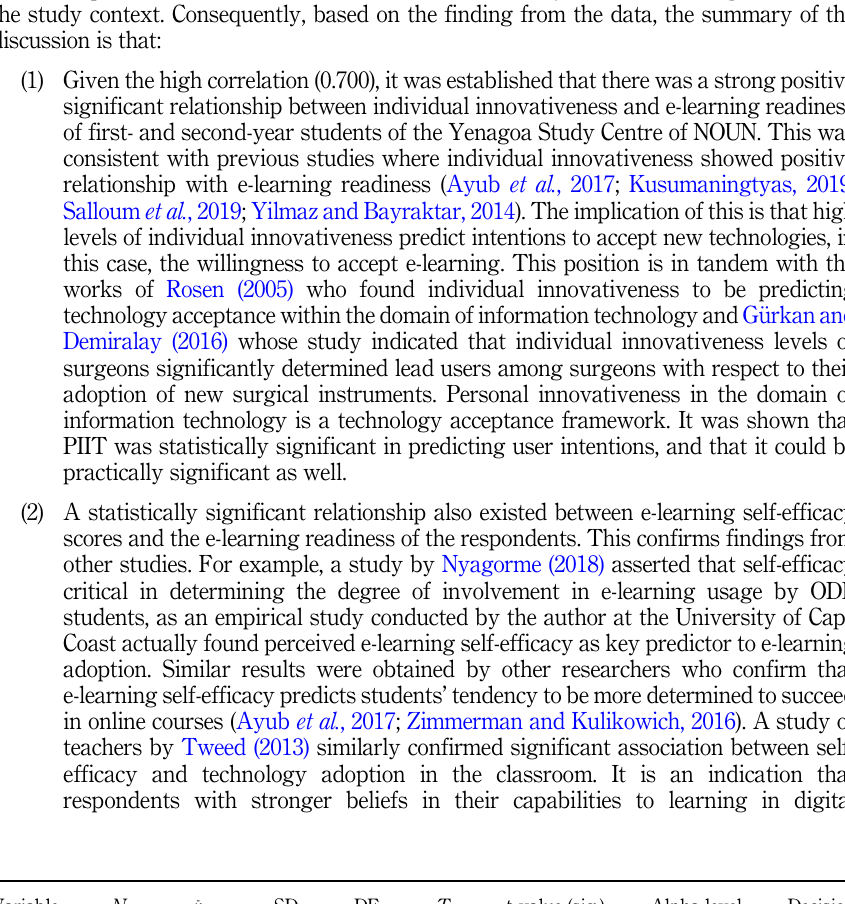
Table 6. T -test analysis of the e-learning readiness of male and female students of the Yenagoa study centre of